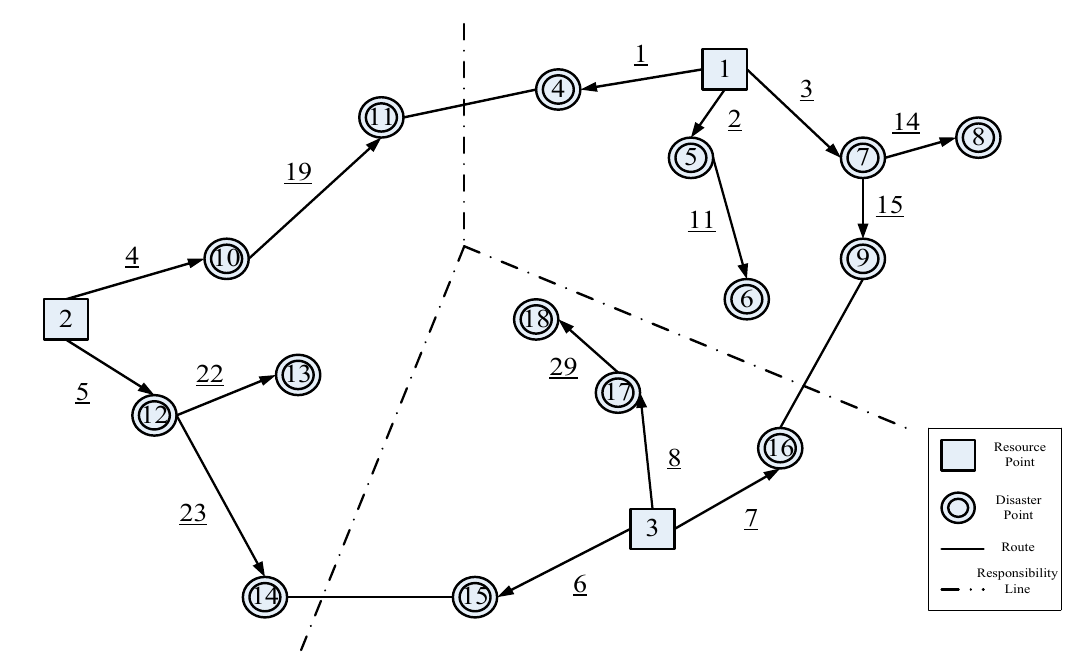
Figure 3. Diagram of emergency repair process based on responsibility area (Case 1). Table 5. Scheduling result for Case 1.